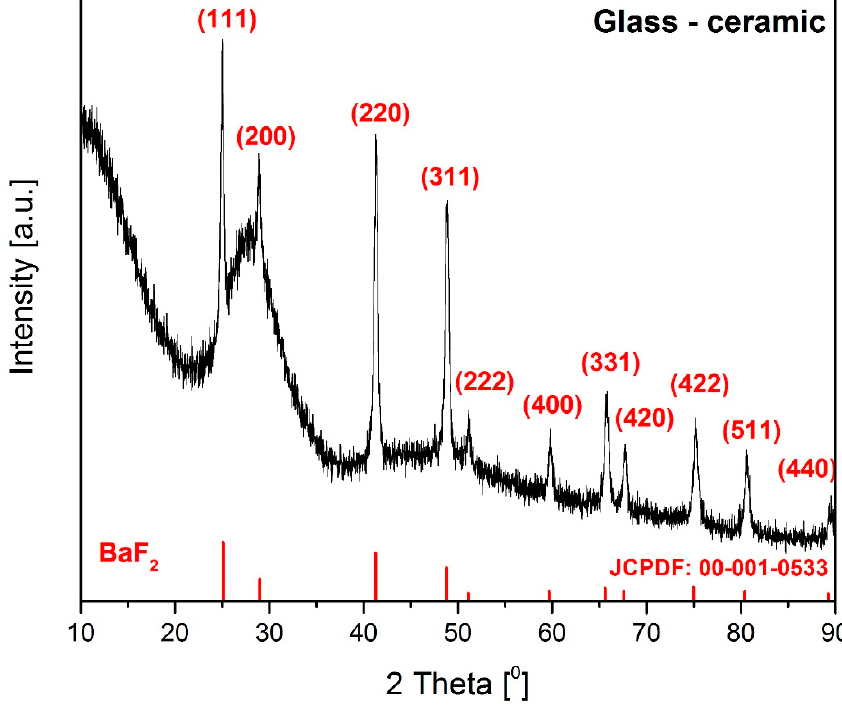
Figure 18. XRD patterns of glass-ceramic.